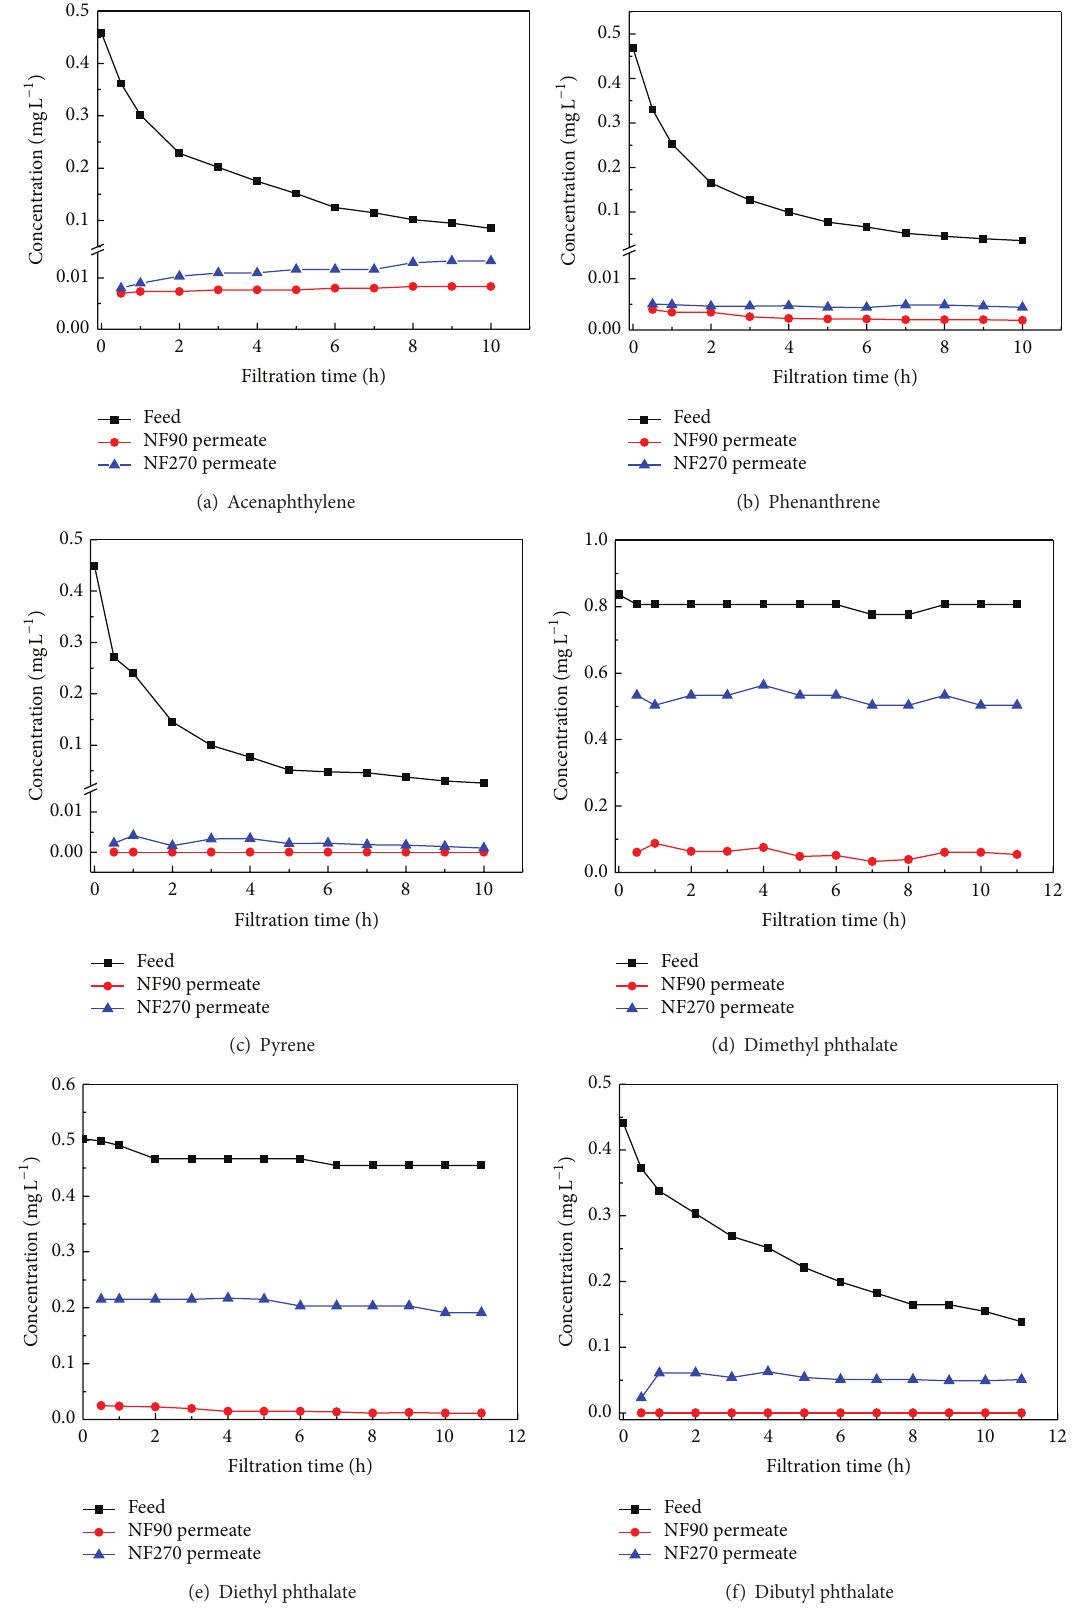
Figure 2: Change in concentration of (a) acenaphthylene, (b) phenanthrene, (c) pyrene, (d) dimethyl phthalate, (e) diethyl phthalate, and (f) dibutyl phthalate during filtration test (applied pressure: 500